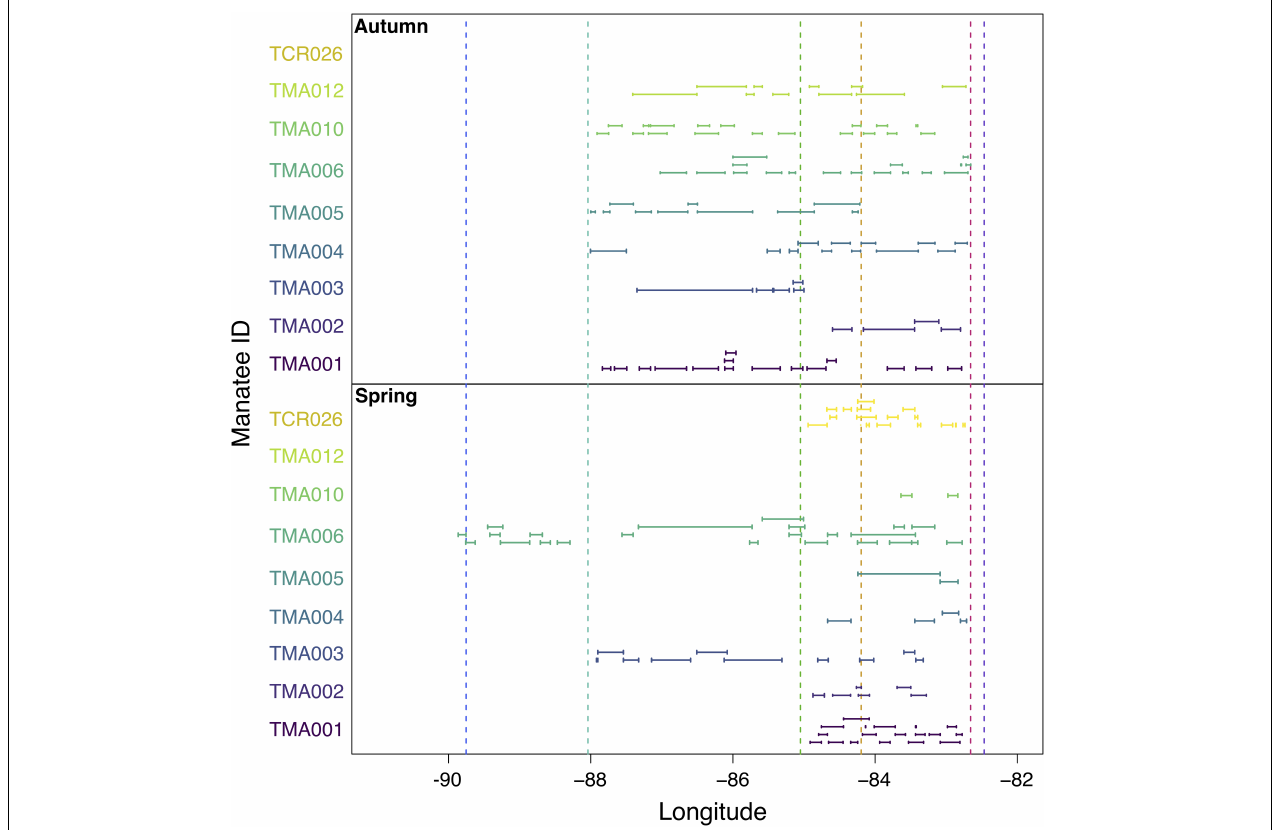
FIGURE 6 | Location of long step lengths ( > 20 km) during autumn and spring migrations. Line caps indicate start and end longitudes of the step length. Colored dashed lines refer to locations shown in Figure 2